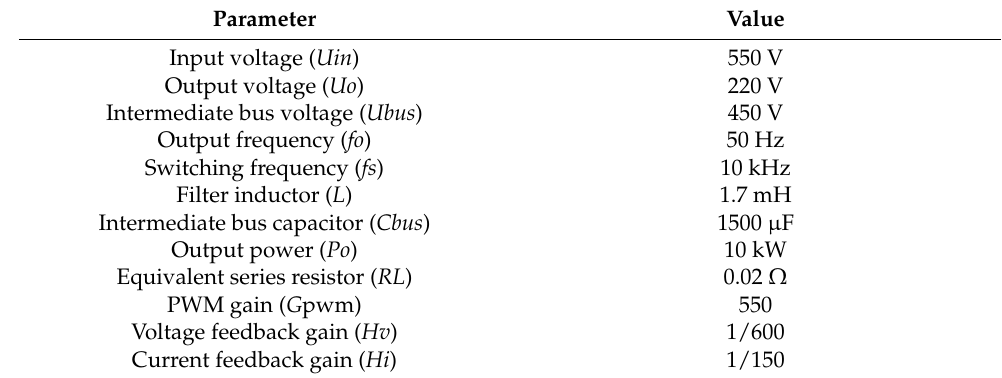
Table 1. Parameters of the